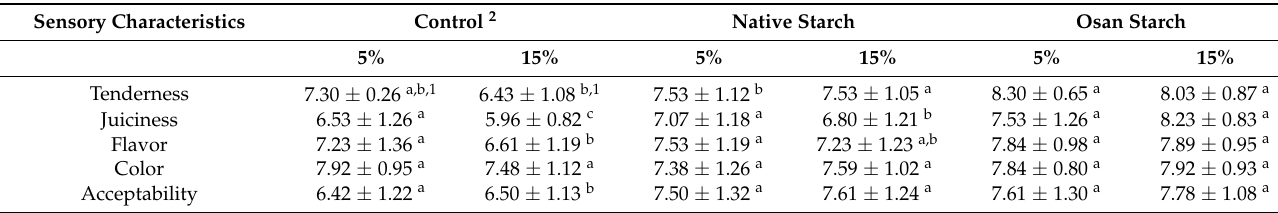
Table 4. The effect of different levels of octenyl-succinylated (Osan) corn starch, native starch, and animal fat on the sensory characteristics of meat patties. The test was based on a 9 points hedonic.